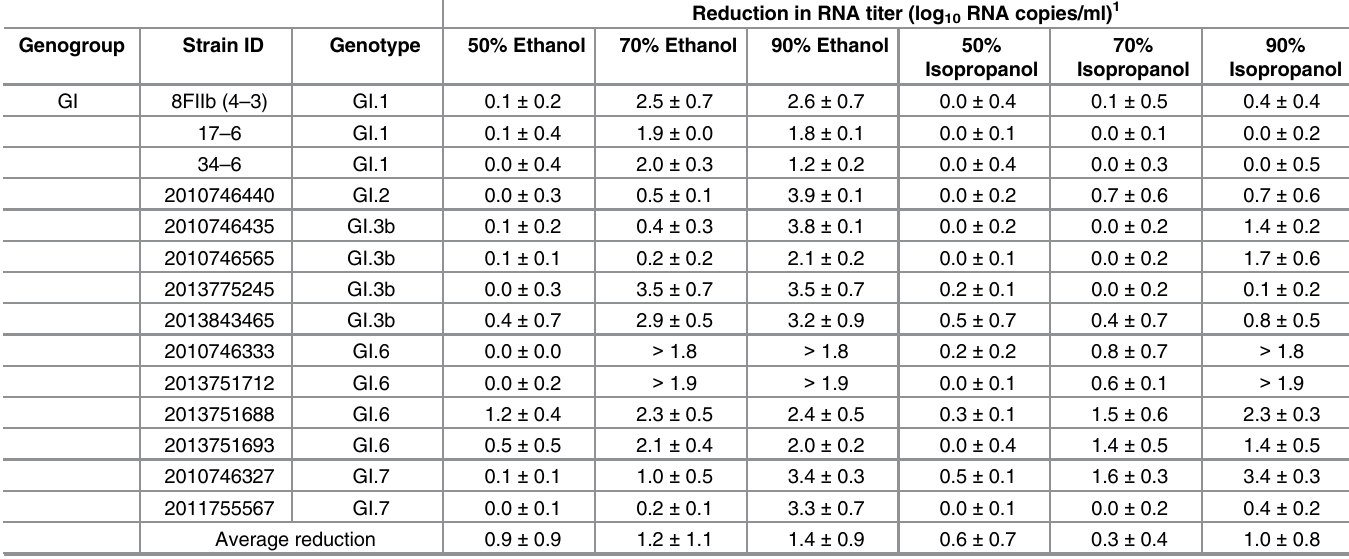
Table 1. Virolysis patterns of GI norovirus strains after exposure to ethanol and Isopropanol.